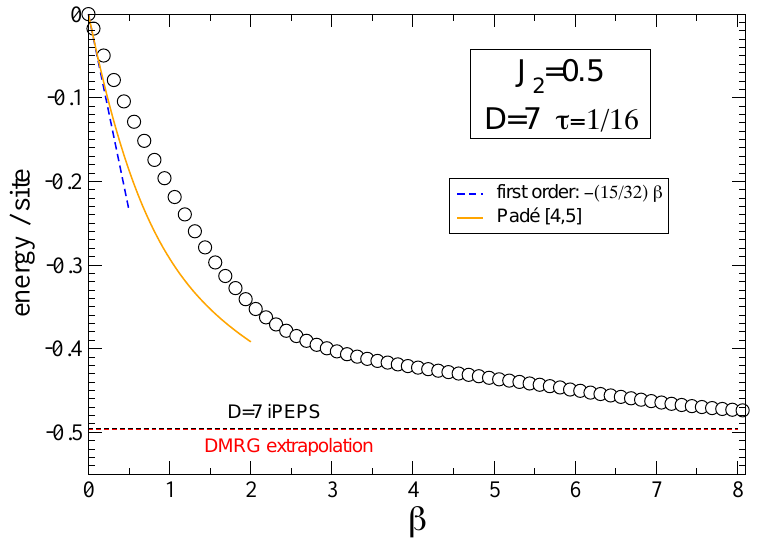
− J = 0.5 vs β = 1 / T , computed model at J 1 2 2 = D 2 and SE. The exact 1st order high-T behavior TE